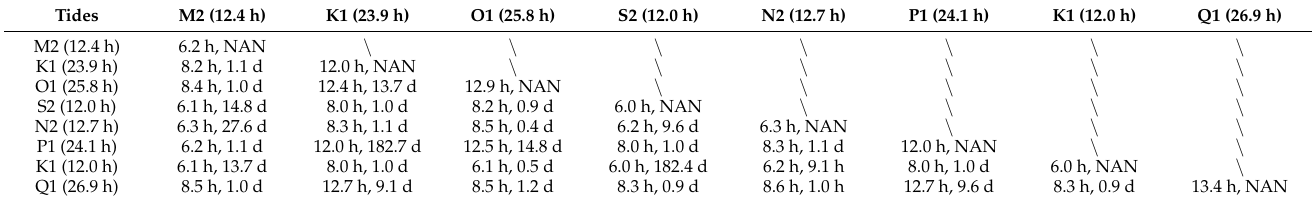
Table 1. Periods of harmonics caused by nonlinear interaction of primary tidal